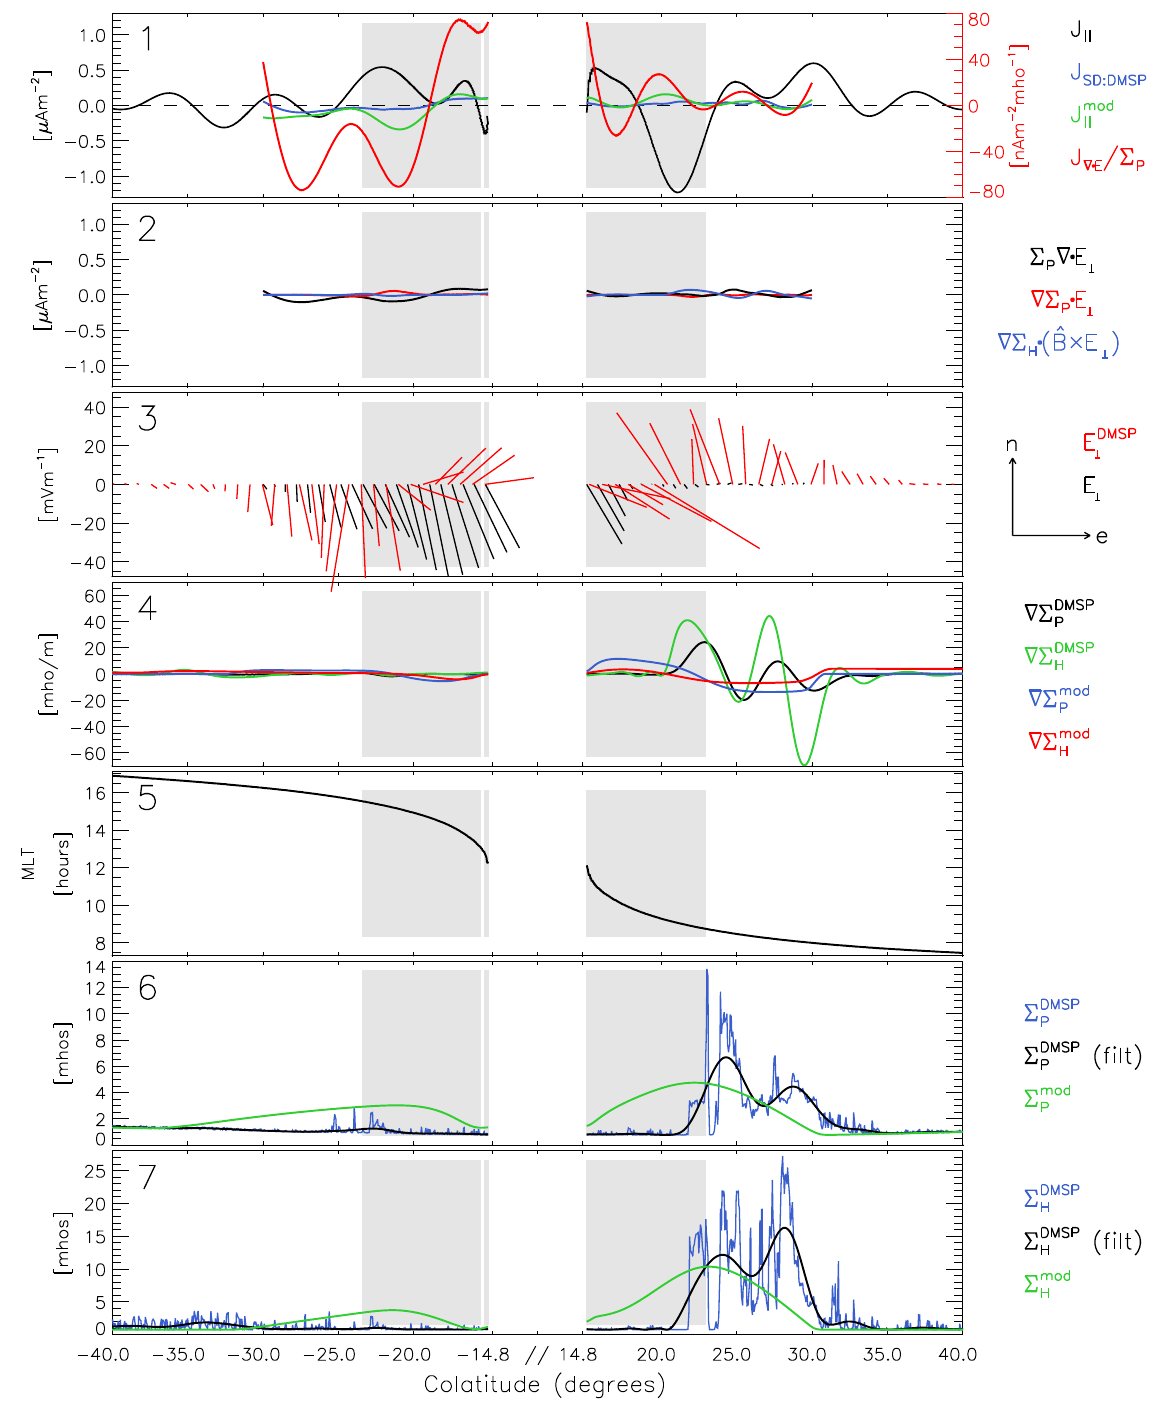
Fig. 16. Iridium, DMSP F13, and radar data for 1 November, 2001. Panel 1: Birkeland currents estimated from various sources (see text), Panel 2: Birkeland current terms from Eq. (3) using DMSP F13 derived conductance, Panel 3: Electric field from the radars and DMSP drift meter data, Panel 4: DMSP F13 and model derived conductance gradients, Panel 5: DMSP satellite MLT coordinate, Panel 6: Pedersen conductance derived from the DMSP F13 data and the conductance model, panel 7: Hall conductance derived from the DMSP F13 data and the conductance model. The lack of a black bar in panel 1 indicates no radar coverage along this track.